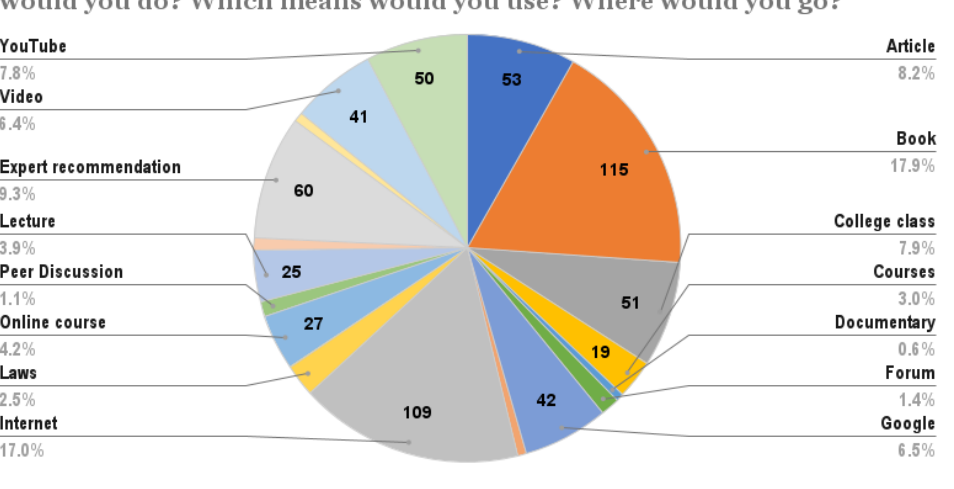
Figure 8. Means used for computing ethics